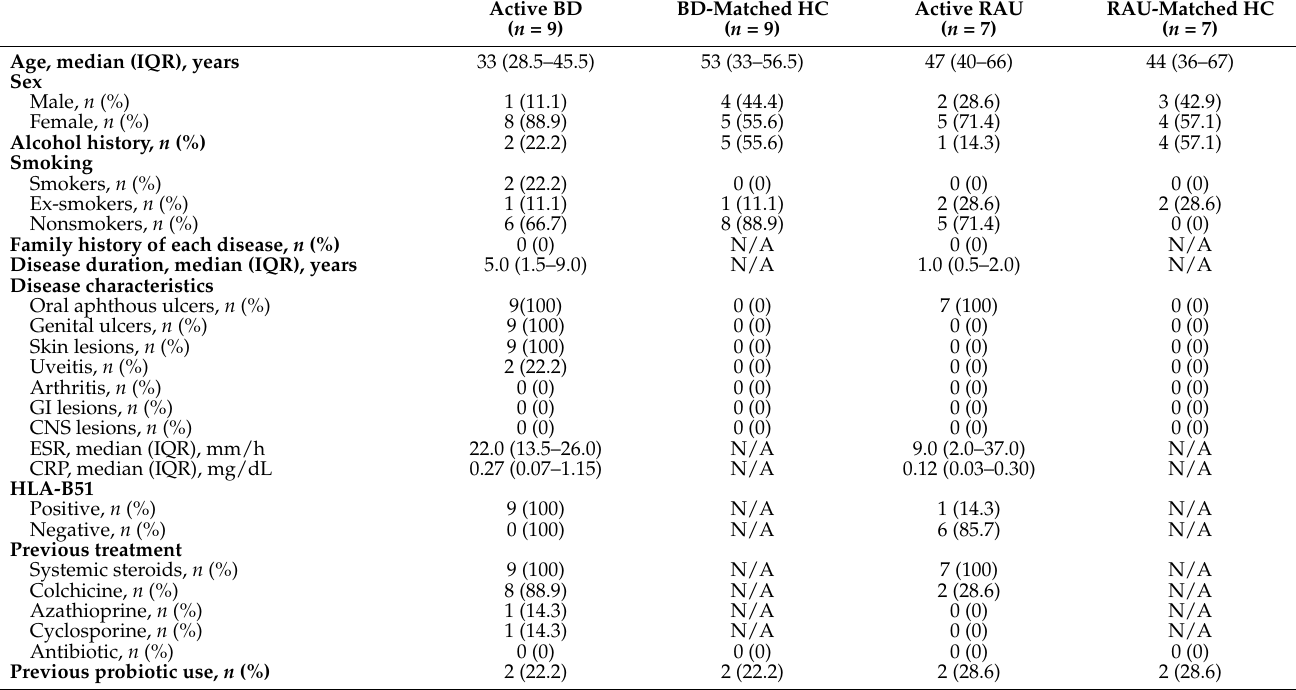
Table 2. Clinical characteristics of the study